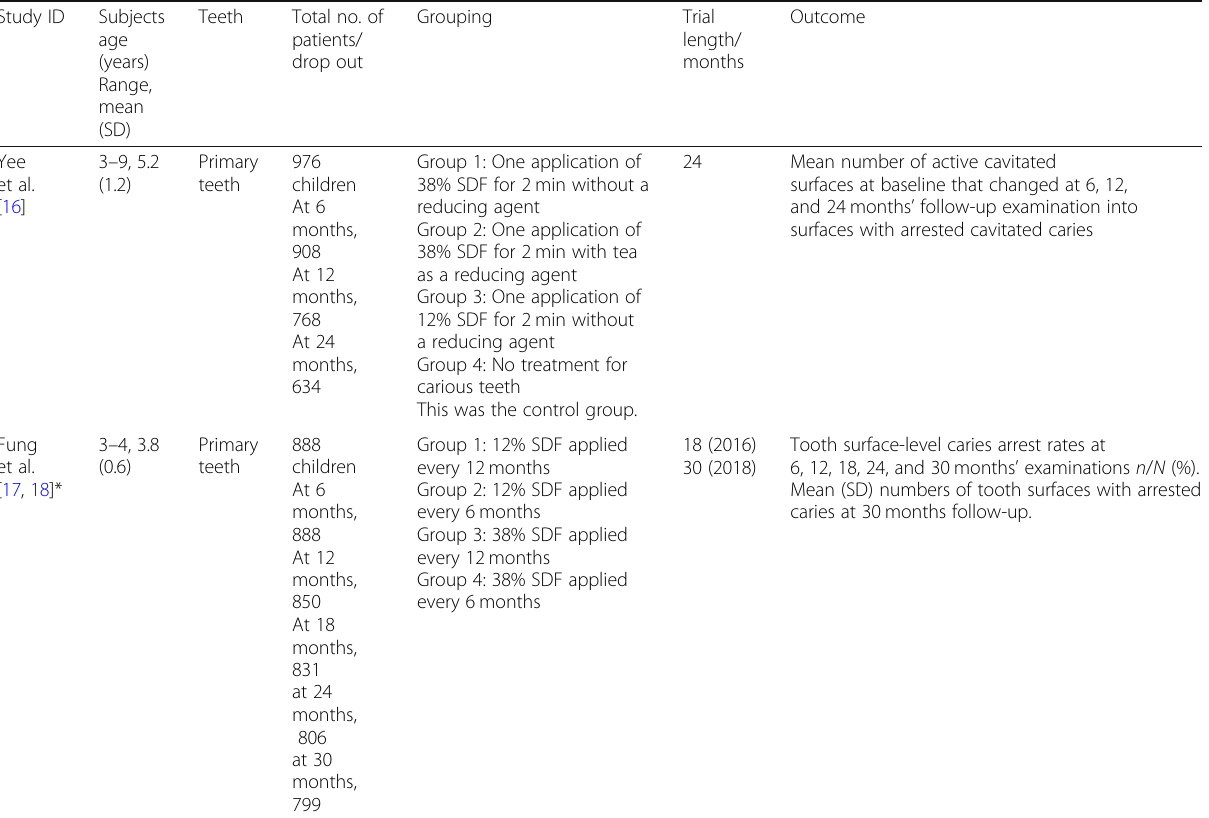
Table 1 Summary of the studies selected for this systematic review Study ID